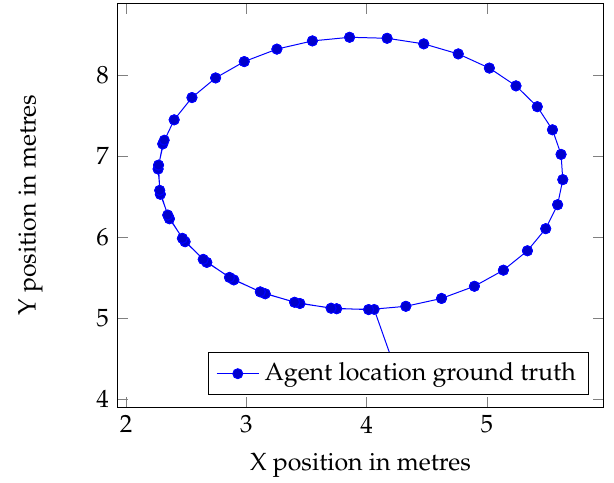
Figure 22. Data of ground truth of the measured agent